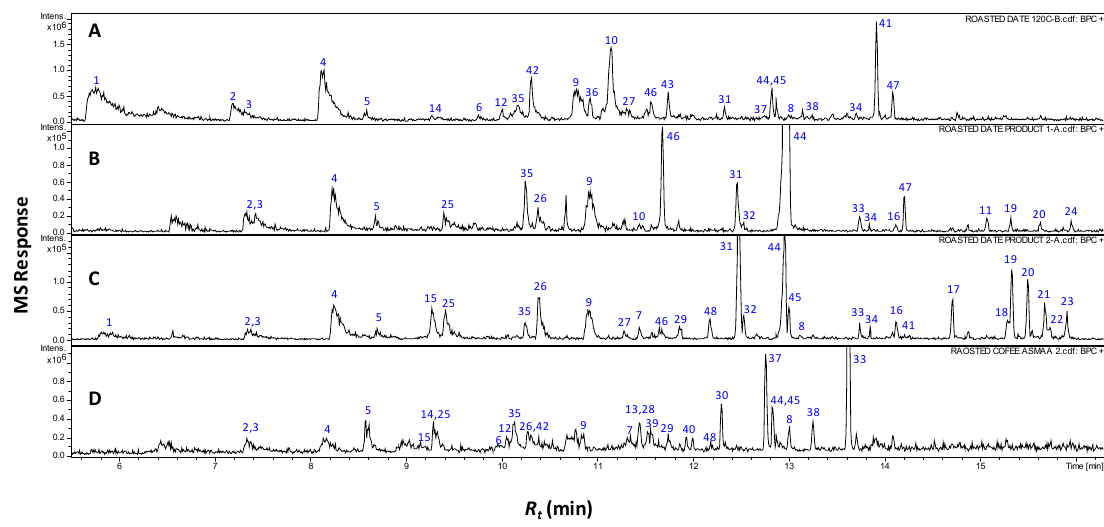
Figure 1. Representative SPME-GCMS chromatograms ( R t 5–16 min) of headspace volatiles derived from roasted pits ( A ), pit product one ( B ), pit product two ( C ) and coffee product ( D ). The corresponding volatile names for each peak follow those listed in Table 1.